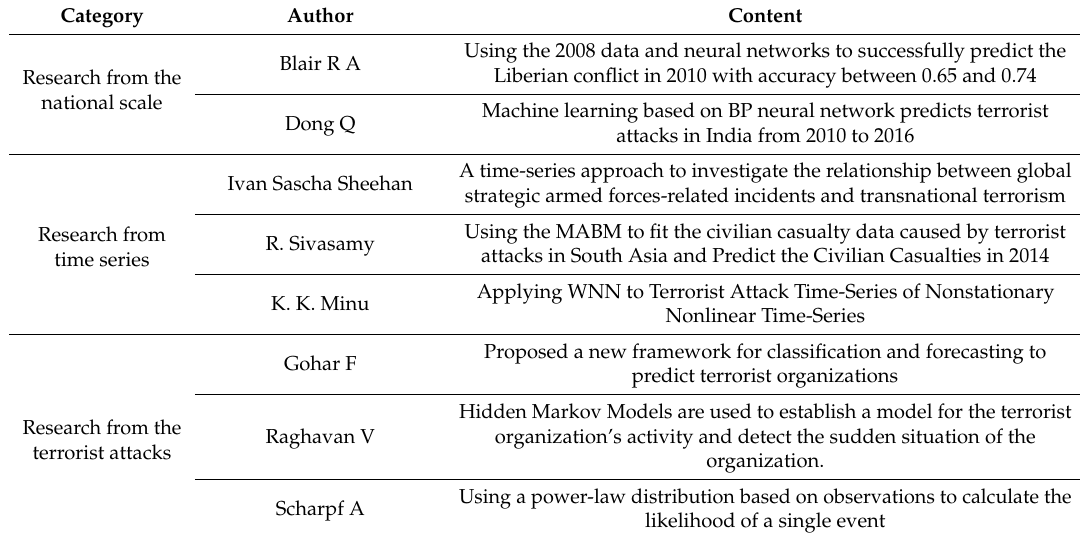
Table 1. Related